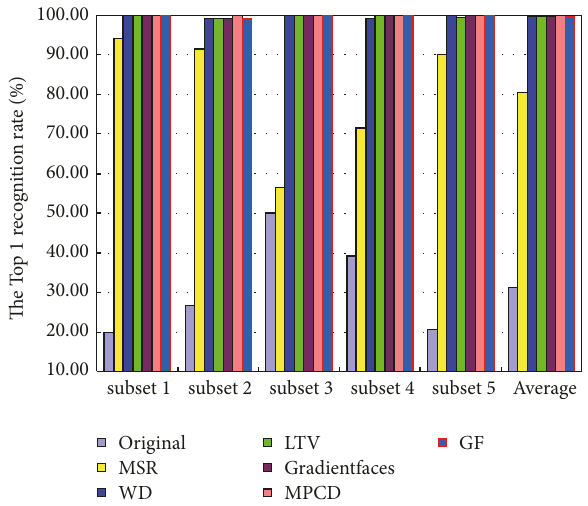
Figure 9: Comparisons on the Top 1 recognition rate (the subset 𝑟 used as the training set).